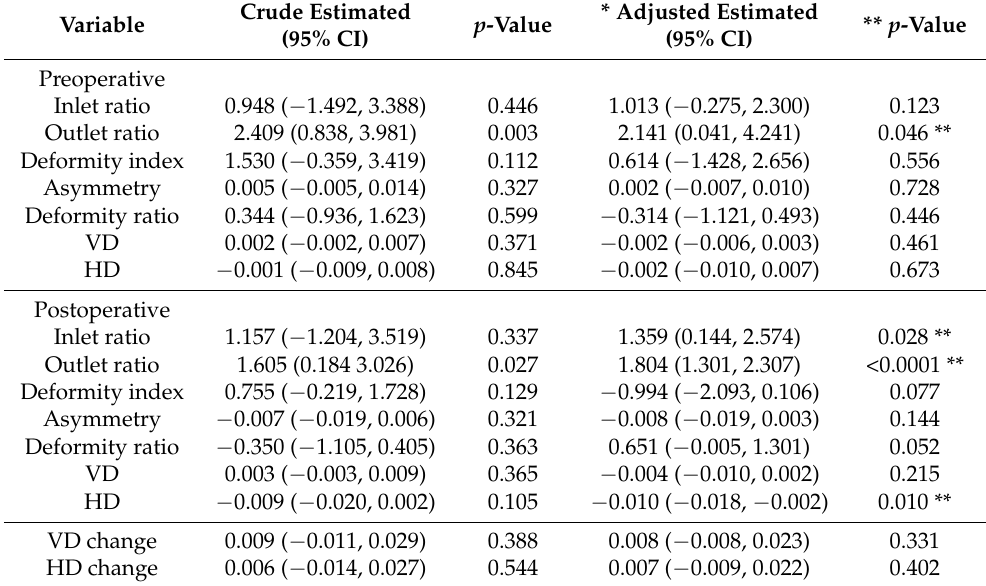
Table 4. Association between EQ − 5D − 5L scores and measurements in the GEE model.